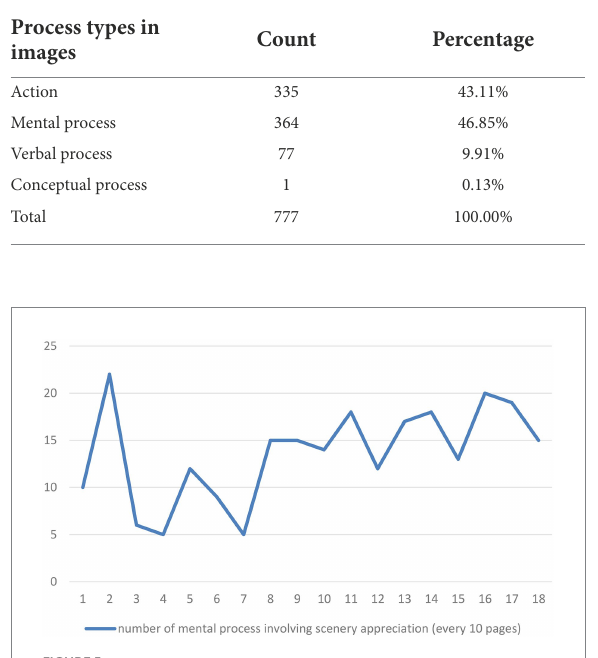
FIGURE 5 Number of visual mental processes involving perception by every 10 pages across the comic book.